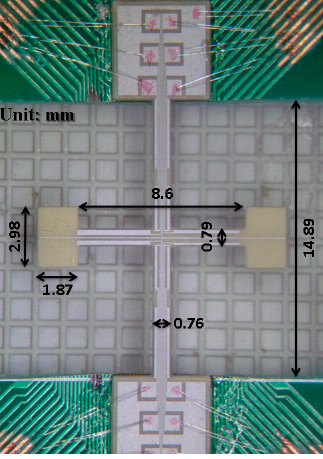
Figure 13. Photo of the fabricated PZT gyroscope.